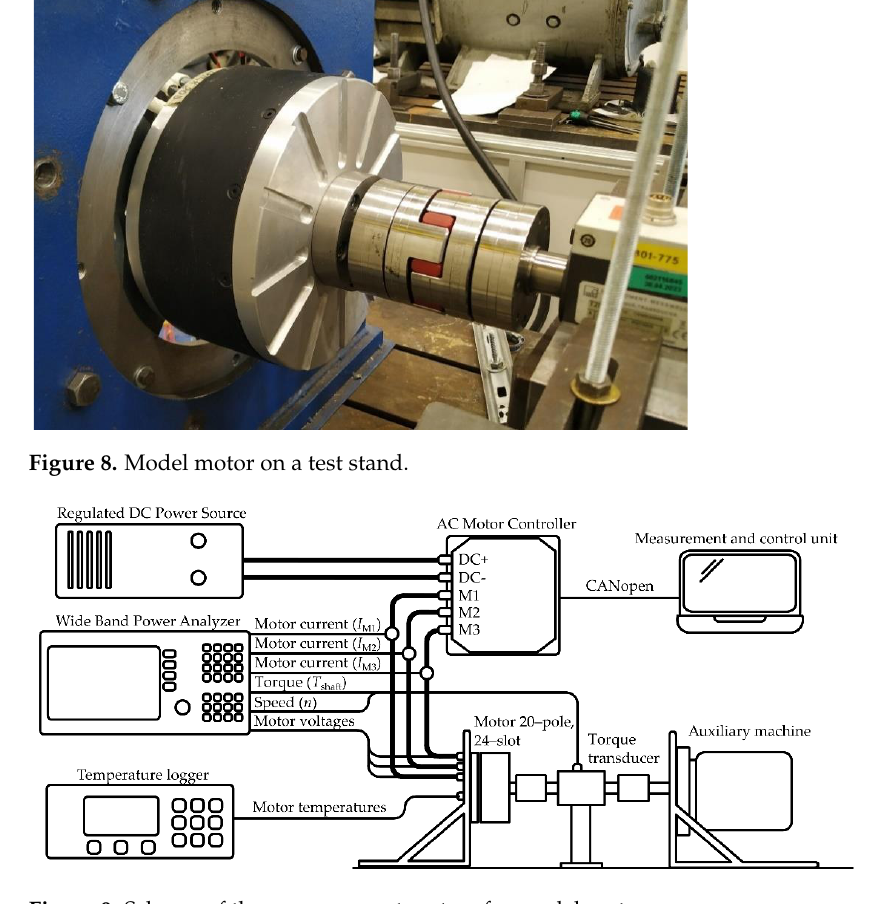
Figure 9. Scheme of the measurement system for model motor.